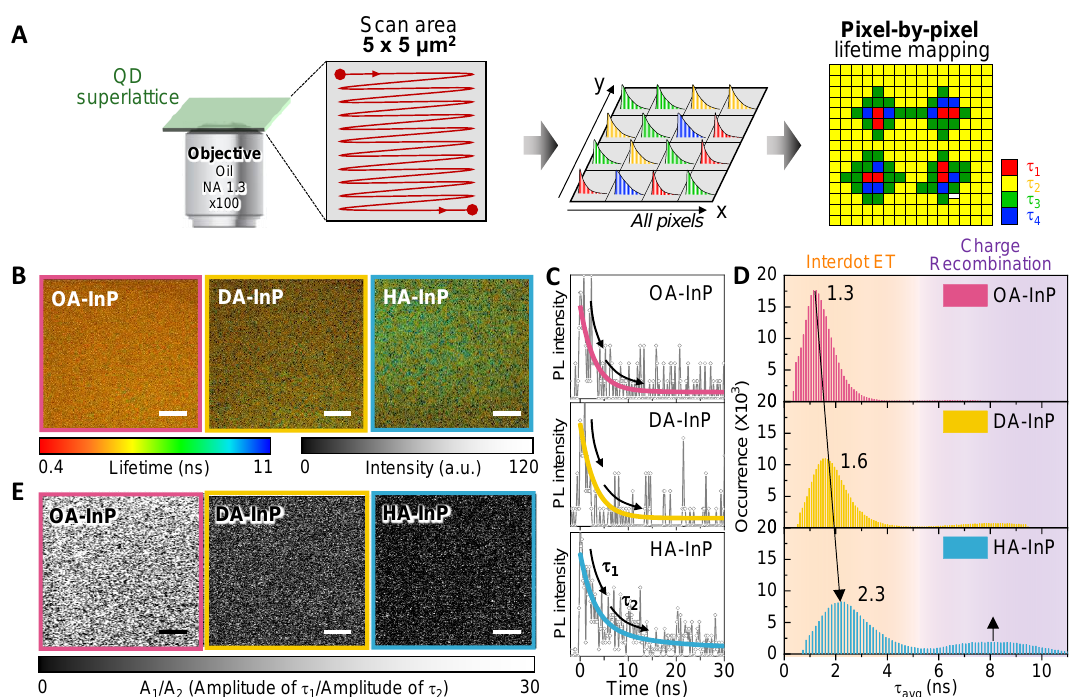
Figure 4. ( A ) A schematic diagram of the fluorescence lifetime imaging microscopy setup; ( B – E ) the PL lifetime–intensity images ( B ), the measured (open circles) and double-exponential-fitted (solid lines) cumulative PL decay profiles over the entire scan area (512 by 512 pixels) ( C ), the PL lifetime distributions at each pixel ( D ), and the extracted energy transfer populations from the PL decay curves ( E ) for the OA-InP, DA-InP, and HA-InP. The scale bar corresponds to 1 µ